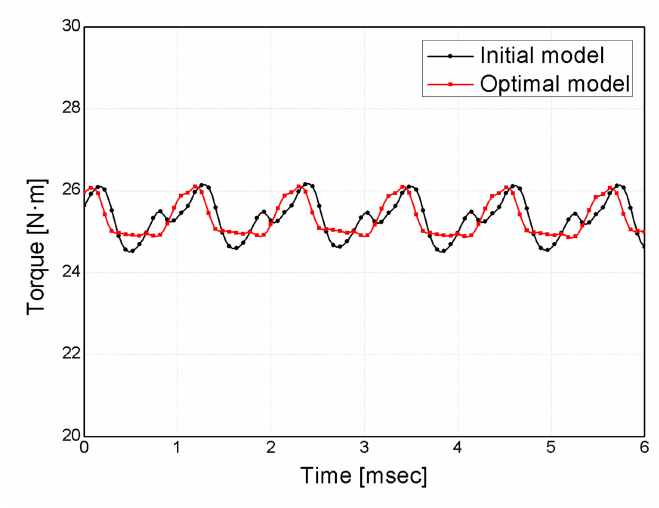
Figure 6. Torque waveforms of the initial and optimal models.